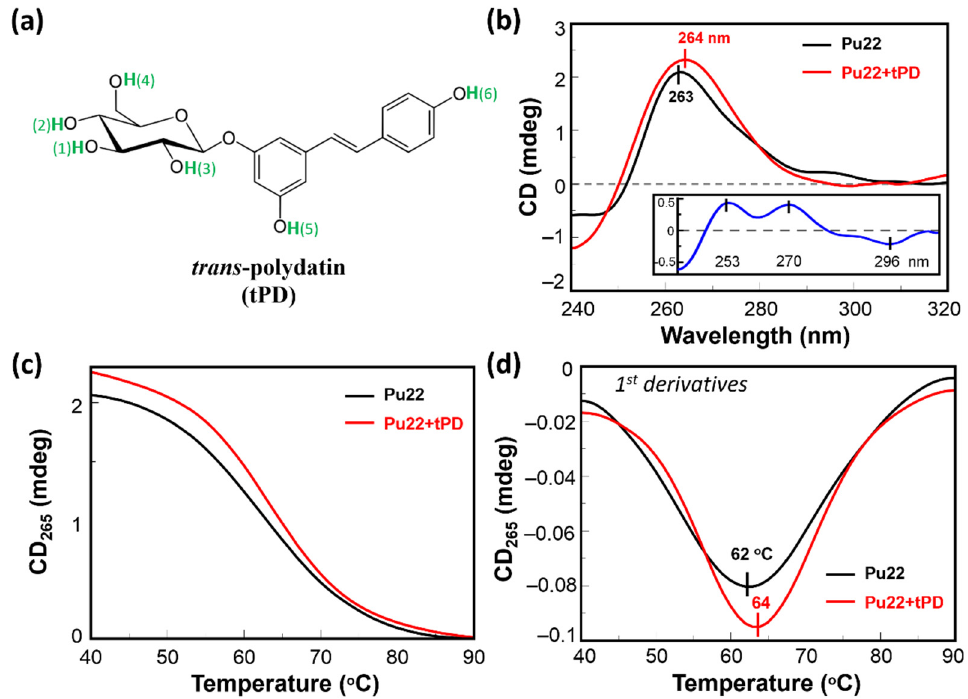
Figure 1. ( a ) Chemical structure of tPD; some atoms are numbered as in the docking program. ( b ) CD spectra of Pu22 2.5 μ M (black) and its complex with tPD (red) at 40 °C. Inset shows the “difference” CD spectrum (tPD-Pu22 (mdeg)–Pu22 (mdeg)). ( c ) CD thermal denaturation curves (CD 265 (mdeg) vs. T (°C)) and ( d ) their first derivatives vs. T plots for Pu22 (2.5 μ M, black) and its complex with tPD (red). All experiments were run in PBS, pH 7.4 (optical path length = 0.1 cm). Then, we studied the effect of tPD on the stability of this G4 DNA by recording, for Pu22 and its mixture with the polyphenol, the CD values at 265 nm as a function of